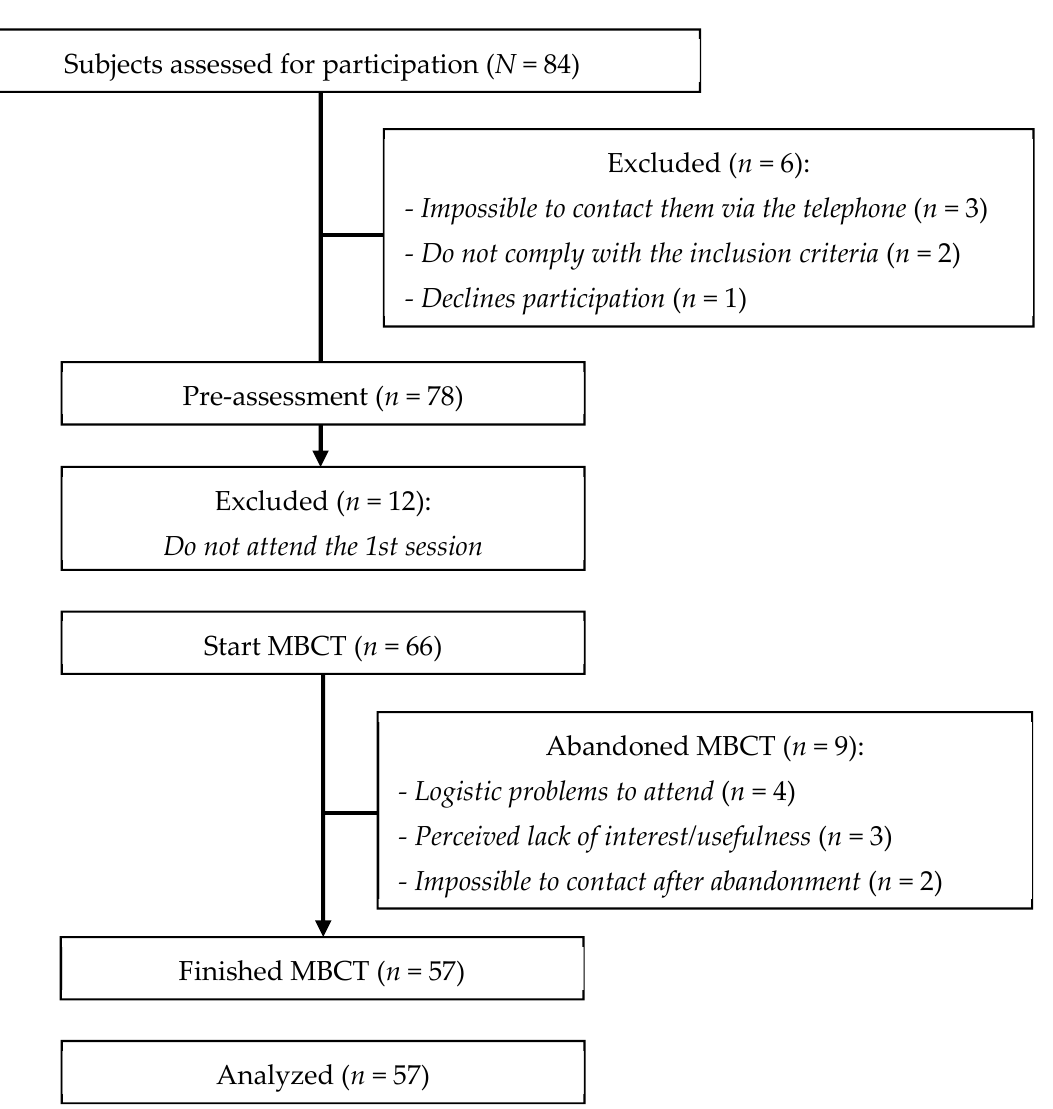
Figure 1. Flow diagram of the